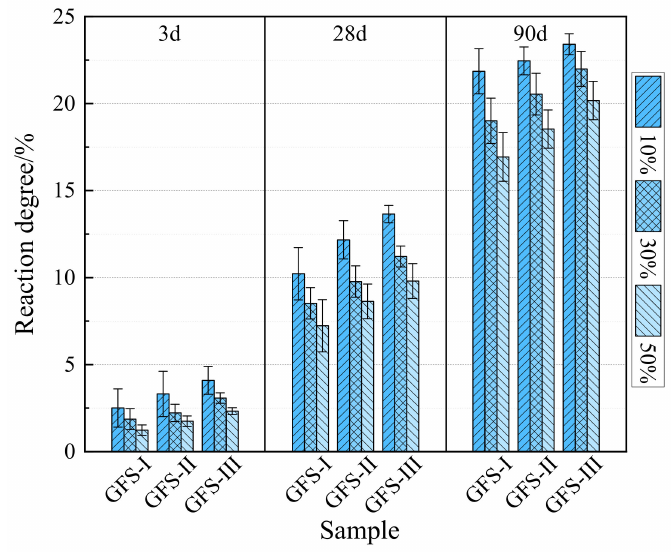
Figure 12. Degrees of reaction and growth rates of the GFS